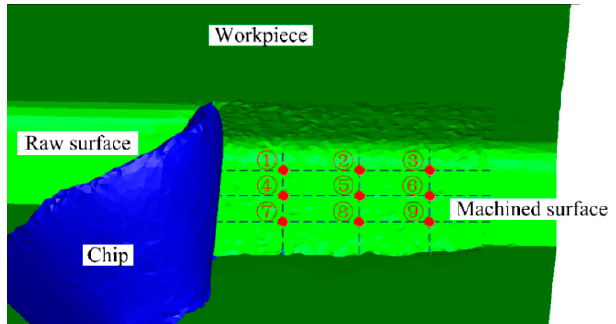
Figure 15. Surface residual stress test point selection (1–9) measurement.